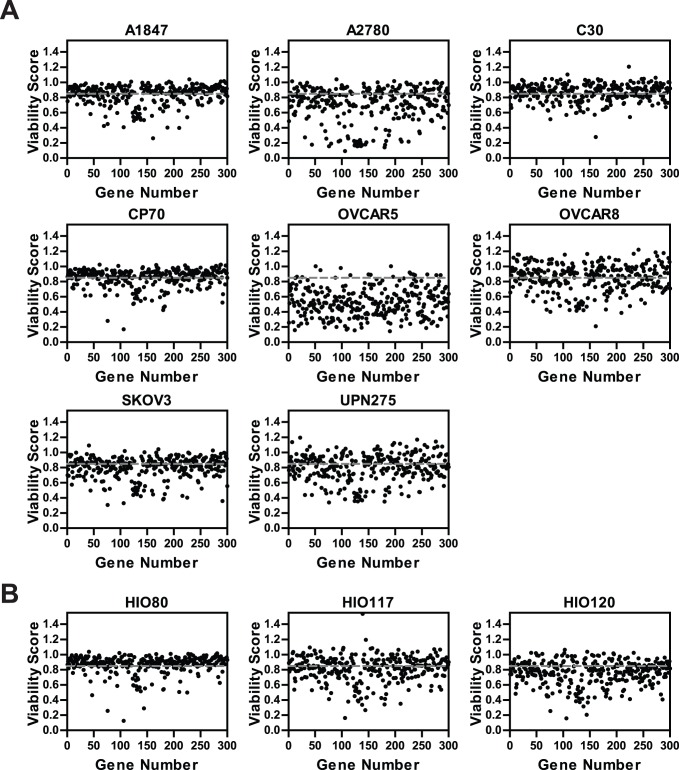
Secondary
screens on a panel of EOC and HIO cell lines. A. Eight EOC cell lines were reverse transfected with siRNAs targeting 300 genes identified from the primary screening of the A1847 cell line using transfection parameters optimized for each cell line (see Table S3). Each circle represents an averaged viability score from technical replicates following silencing of a particular gene. The grey dotted line represents the cut off value for the viability score (0.85) to select hits. B. Three HIO cell lines were transfected using parameters optimized for each (see Table S3).